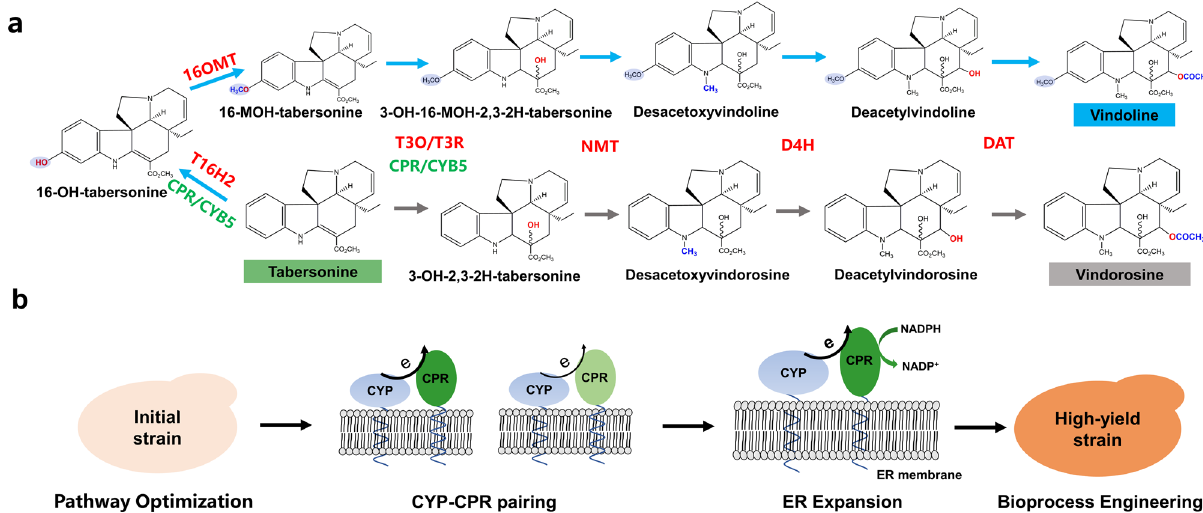
Fig. 1 Construction of a vindoline-producing yeast strain. a Metabolic pathway for the biosynthesis of vindoline/vindorosine from tabersonine. Eight plant-derived enzymes should be functionally expressed in yeast to reconstitute the vindoline biosynthetic pathway. T16H2 : tabersonine 16-hydroxylase 2; 16OMT : 16-hydroxytabersonine O-methyltransferase; T3O : tabersonine 3-oxygenase; T3R : tabersonine 3-reductase; NMT : 3-hydroxy-16-methoxy-2,3- dihydrotabersonine-N-methyltransferase; D4H : desacetoxyvindoline-4-hydroxylase; DAT : deacetylvindoline-4-O-acetyltransferase; CPR : cytochrome P450 reductases; 16-OH-tabersonine: 16-hydroxytabersonine; 16-MOH-tabersonine: 16-methoxytabersonine; 3-OH-16-MOH-2,3-2H-tabersonine: 3-hydroxy-16- methoxy-2,3-dihydro-tabersonine; 3-OH-2,3-2H-tabersonine: 3-hydroxy-2,3-dihydro-tabersonine. b Brief engineering strategies for the construction of an ef fi cient S. cerevisiae cell factory for high-yield production of vindoline from tabersonine. Different colors represented CPRs with different origins, e represented the electron transfer between CYPs and